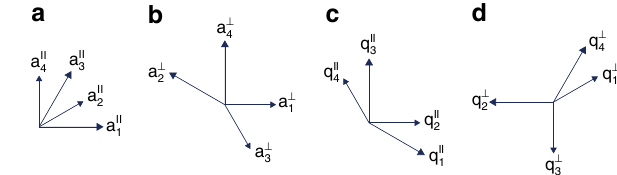
Fig. 2 Basis vectors in real and in reciprocal space. a , b Projected basis vectors of k = 3 tilings in the physical and in the perpendicular space a k j and a ? j , respectively. c , d Projected reciprocal-space basis vectors in the physical and in the perpendicular space q k j and q ? j ,